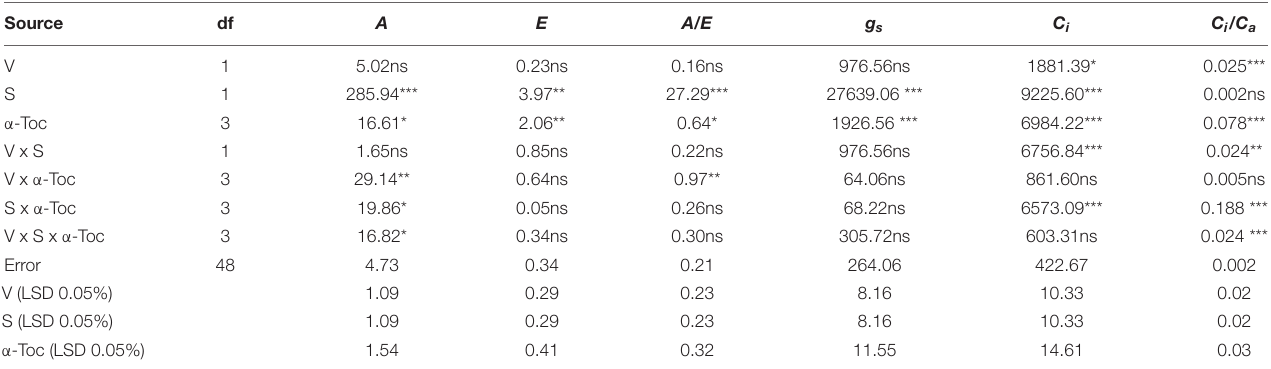
TABLE 2 | Analysis of variance (mean squares) for leaf gas exchange attributes of okra plants treated with α -tocopherol as foliar spray under saline and non-saline conditions. Source